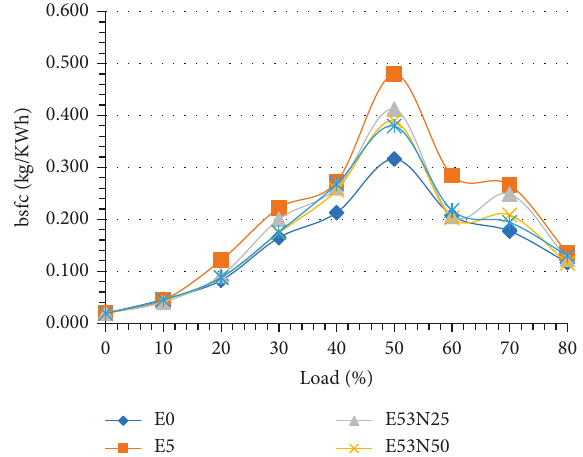
Figure 14: The effect of 3 elemental nanoparticles addition in E5 on engine fuel consumption.